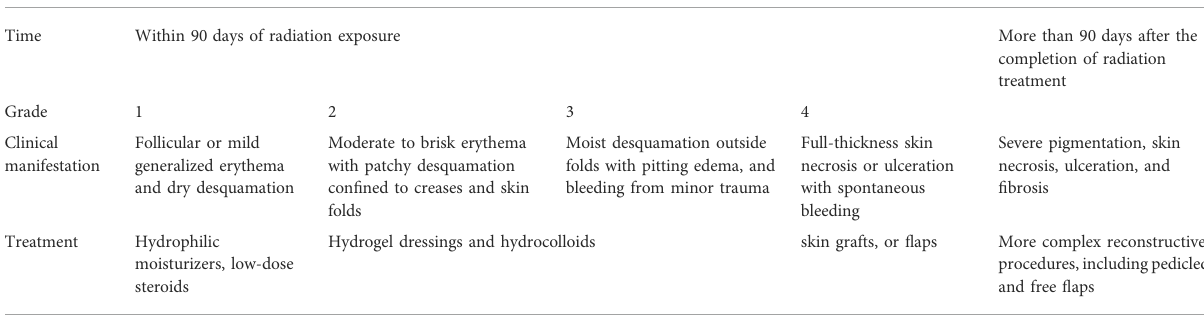
TABLE 1 Classi fi cation of radiation-induced skin